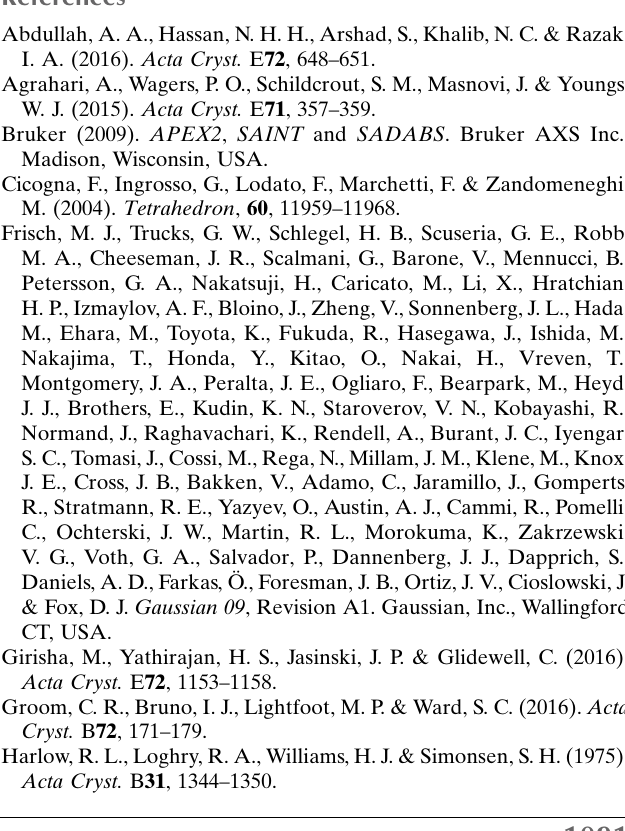
Bruker SMART APEXII DUO CCD area-